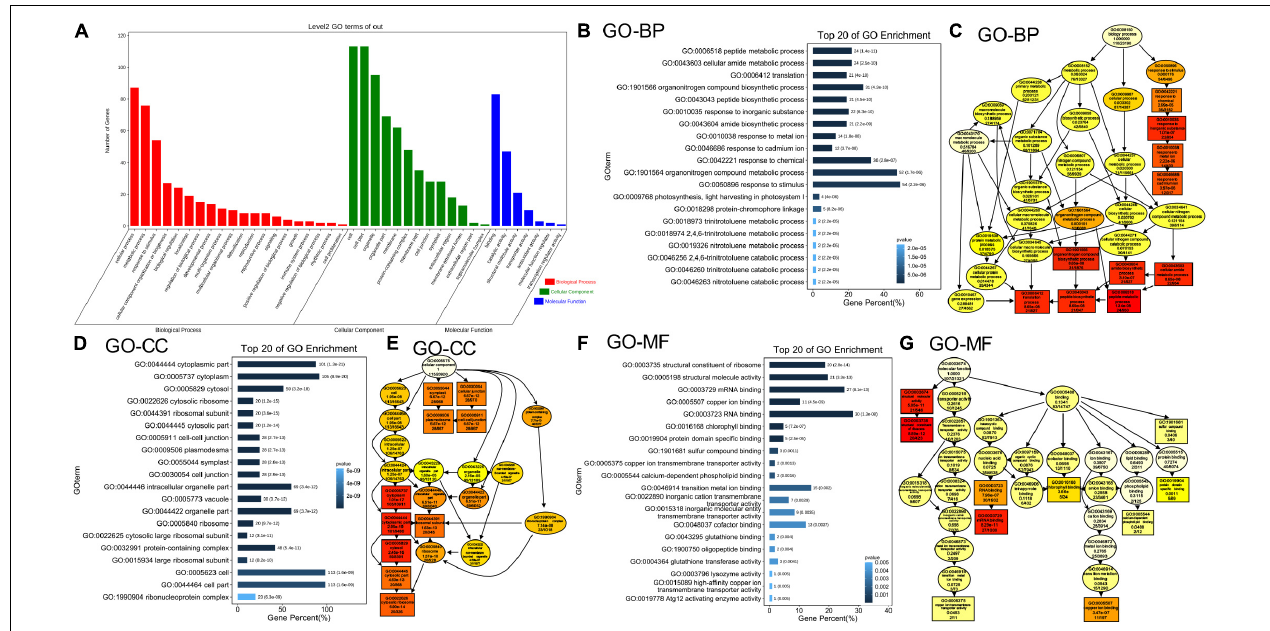
FIGURE 4 | Gene Ontology (GO) classification of the differently accumulated proteins (DAPs). (A) DAP distribution in three GO terms of biological process (BP), cellular component (CC), and molecular function (MF). X axis represents GO terms. Y axis represents number of genes. (B) Top 20 GO enrichment terms in BP. X axis represents gene percentage. Y axis represents GO terms. The number on each column indicates DAP number, followed by p- value in the brackets. The same in panel (D,F) . (C) The functional categories of GO terms in BP are shown as a diagram. (D) Top 20 GO enrichment terms in CC. (E) The functional categories of GO terms in CC. (F) Top 20 GO enrichment terms in MF. (G) The functional categories of GO terms in